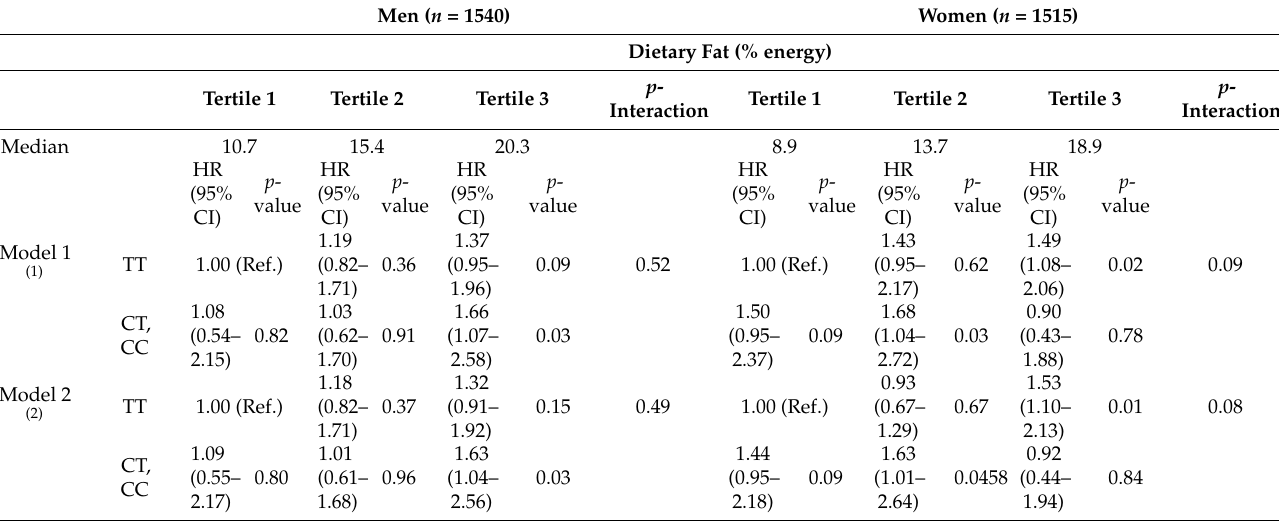
Table 6. Association between COBLL1 rs6717858 genotypes and incidence of obesity, stratified by tertiles of dietary fat intake. Men ( n = 1540) Women ( n =